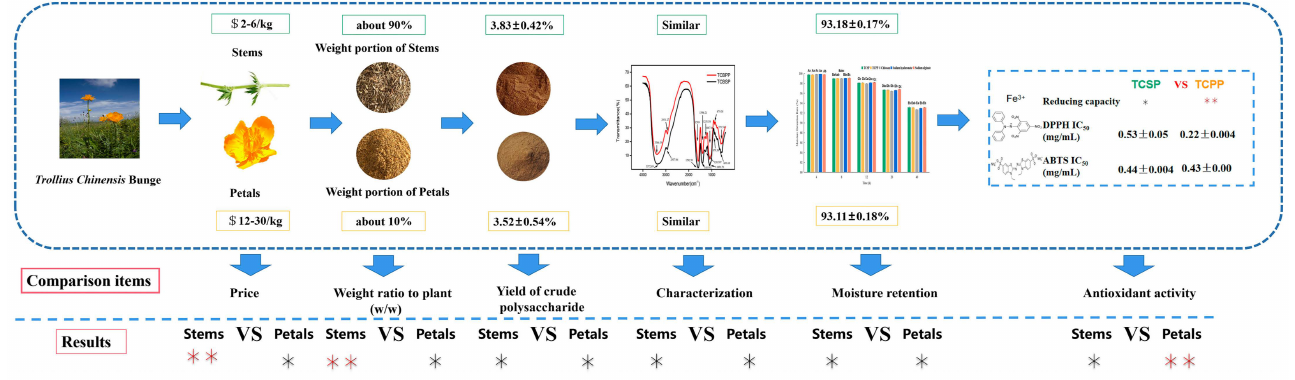
Figure 5. Polysaccharide comparisons of TCSP and TCPP. *: the comparison items are similar, **: the comparison items are better. TCSP: polysaccharides from stems of Trollius chinensis Bunge; TCPP: polysaccharides from petals of Trollius chinensis